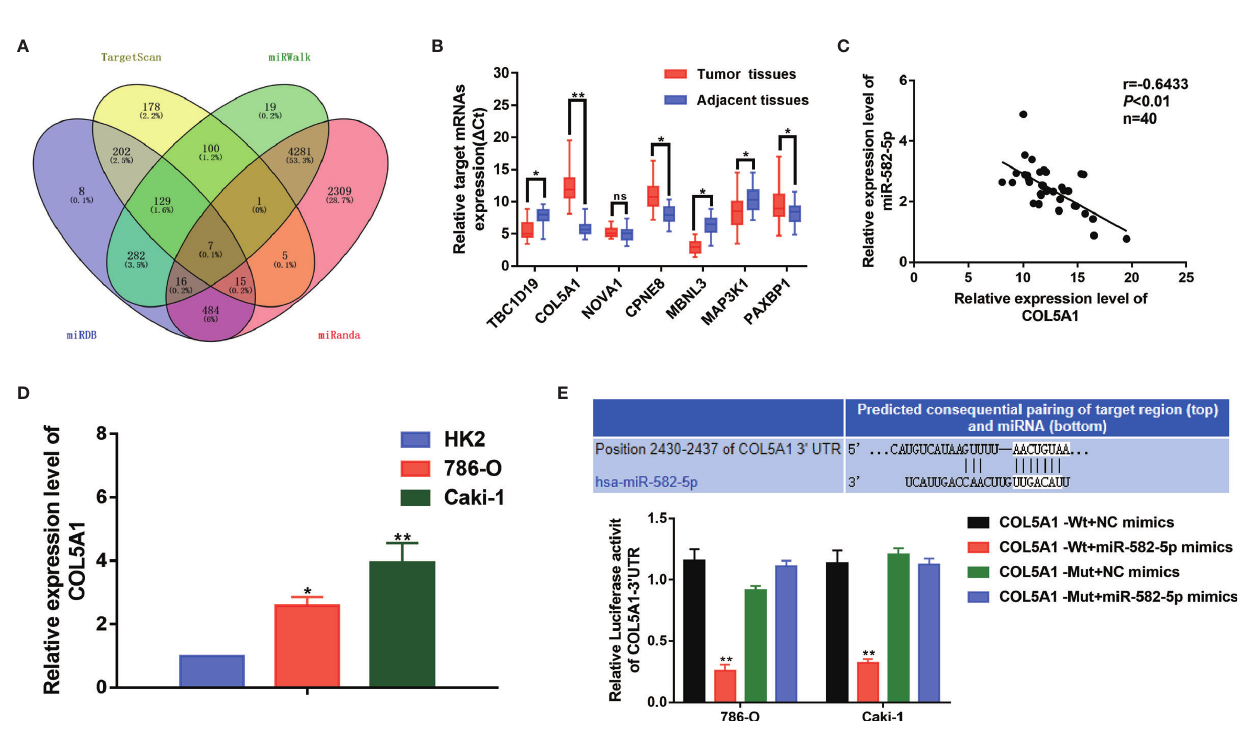
FIGURE 4 | COL5A1 was a potential target of miR-582-5p. (A) The candidate gene targets were predicted by intersecting outputs from four distinct prediction algorithms (TargetScan, miRDB, miRWalk, and miRanda). (B) qRT-PCR assay con fi rmed the relative expression of seven candidate target mRNAs of miR-582-5p in 40 paired ccRCC cancer tissues and corresponding paracancerous normal tissues. (C) There was an inverse correlation between miR-582-5p and COL5A1. (D) COL5A1 mRNA in HK2 cells and ccRCC cell lines (786-O and Caki-1 cells) were investigated by qRT-PCR. (E) The potential miR-582-5p seed region at the 3 ′ - UTR of COL5A1 mRNA was computationally predicted. 786-O and Caki-1 cells were co-transfected with miR-582-5p mimics (or NC) with COL5A1-Wt (or COL5A1- Mut) vector. Luciferase activity was normalized by the ratio of fi re fl y and Renilla luciferase signals. The data are shown as the mean ± SD (* P < 0.05; ** P < 0.01). The experiments were repeated three times with similar